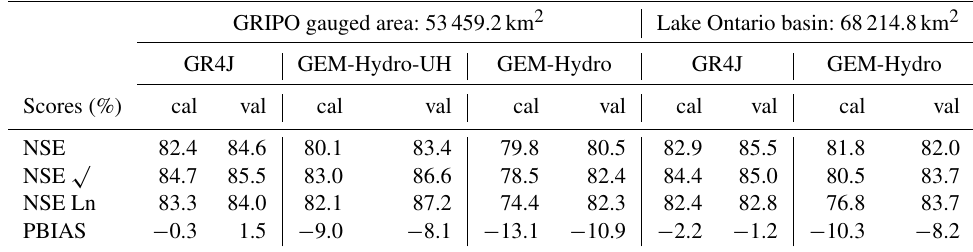
Table 5. Performance for the GRIP-O gauged area and the whole Lake Ontario basin (Fig. 2) with GR4J and globally calibrated GEM- Hydro-UH and GEM-Hydro models. Cal., val.: calibration and validation periods, respectively. GRIPO gauged area: 53459.2km 2 GEM-Hydro-UH